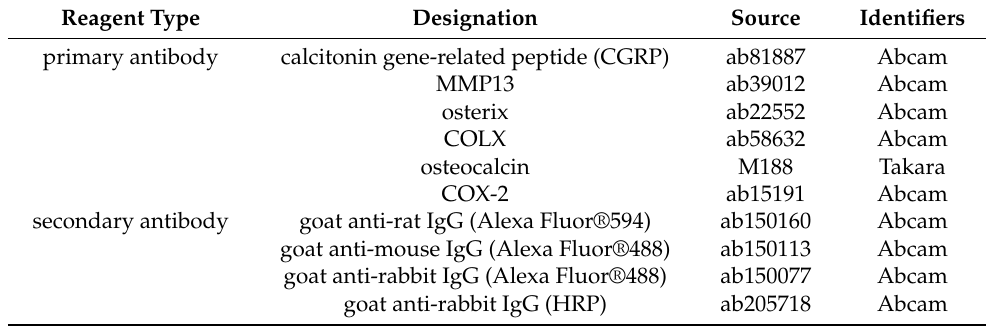
Table 1. Antibody